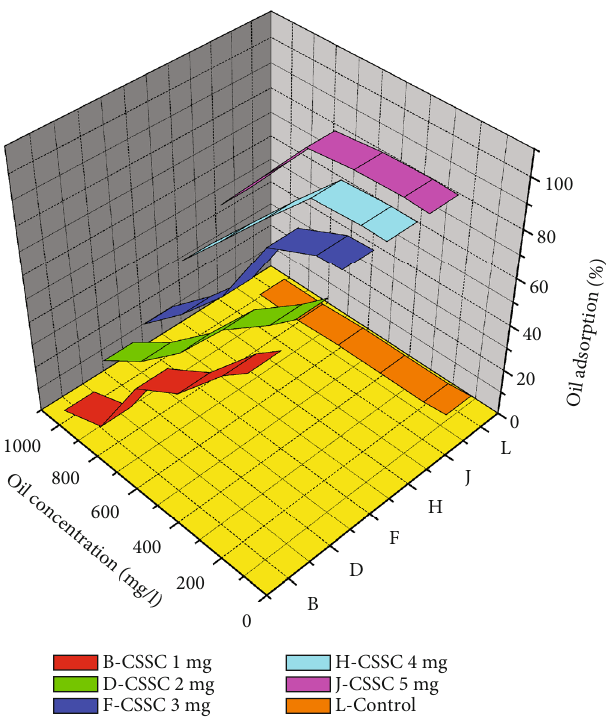
Figure 5: Oil removal e ffi ciency of CSSC from